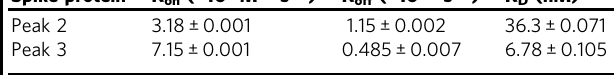
Values after ± correspond to the residual standard deviation. Each experiment was repeated independently twice with similar